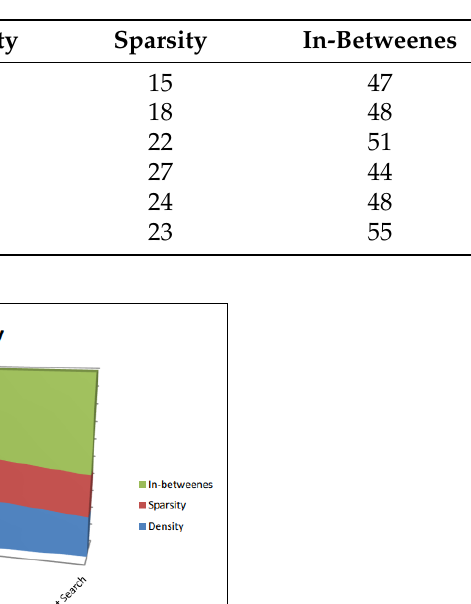
Table 7. Communities % with comparable Users-Nodes.